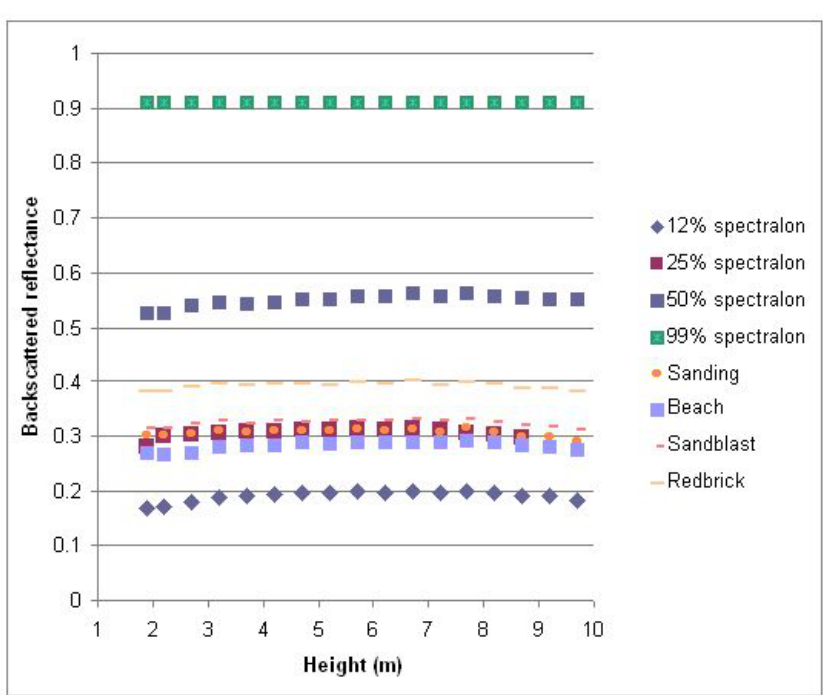
Figure 5. FARO: 2009 scissor lift experiment results calibrated with the 99% Spectralon at the same distance as the target. The samples: crushed redbrick (denoted ‘Redbrick’ in the plot legend), beach sand from Kivenlahti (Beach), sanding gravel (Sanding), and sandblasting sand